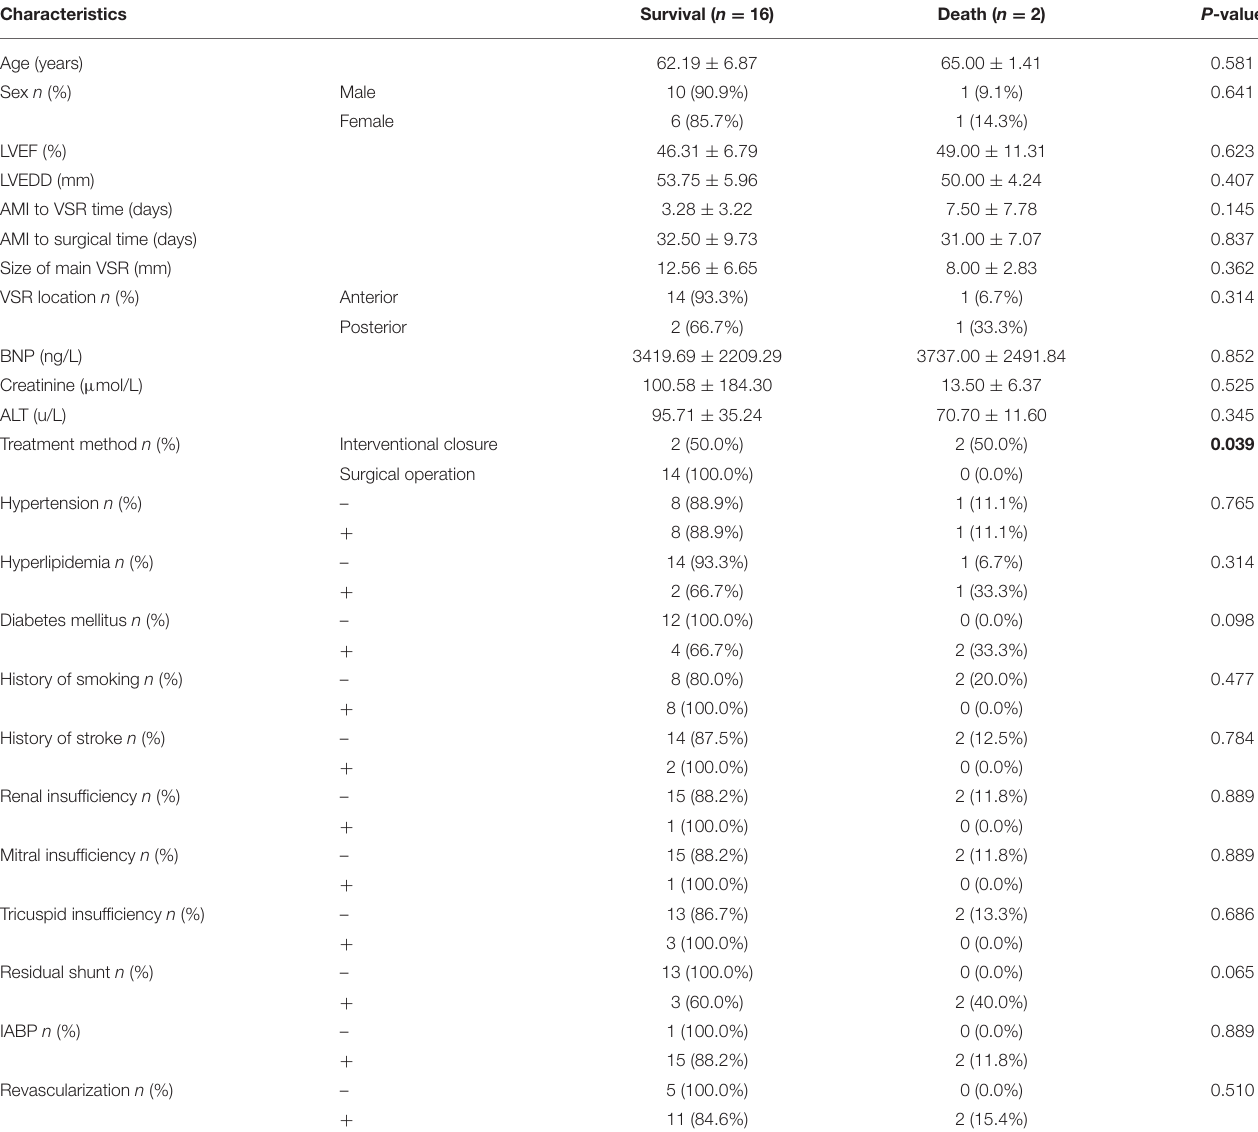
TABLE 5 | Baseline characteristics of discharged patients with follow-up.